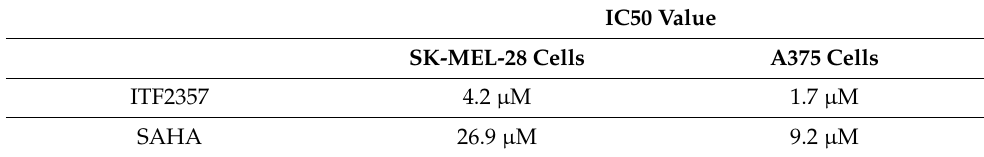
Table 1. IC50 values of ITF2357 and SAHA in SK-MEL-28 and A375 cells.